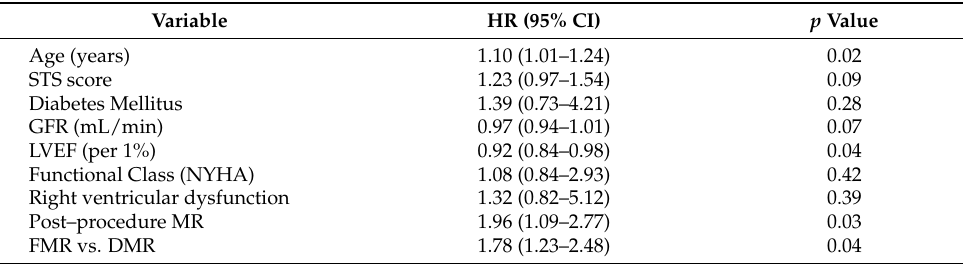
Table 5. Cox regression for MACE.